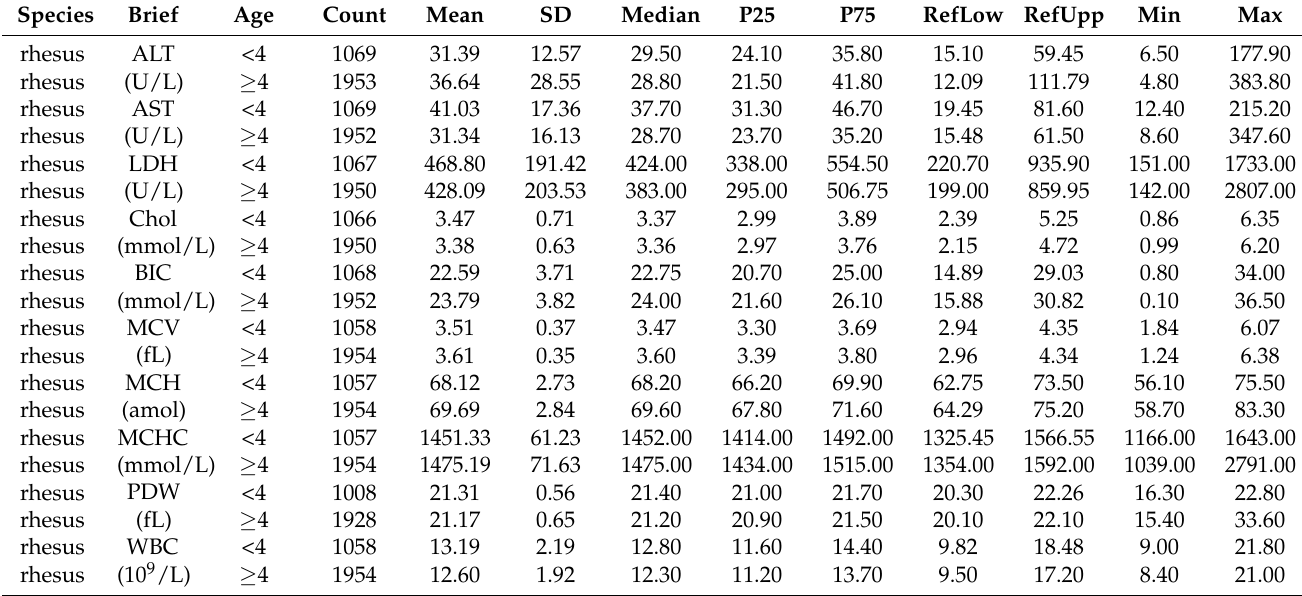
Table 11. Combined reference intervals for gender, partitioned per age.